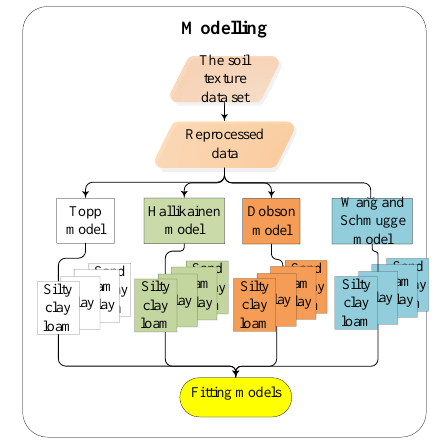
Figure 1 . The flowchart for comparing the four soil models